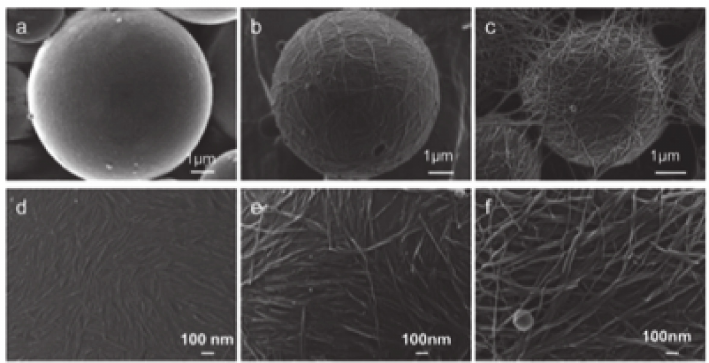
Figure 5. SEM images of polymerized styrene–water emulsions stabilized by cellulose nanomaterials of di ff erent sizes. ( a , d ) Cellulose nanocrystals from cotton, ≈ 200 nm in length. ( b , e ) Bacterial cellulose nanocrystals, ≈ 900 nm in length. ( c , f ) cellulose nanofibers from cladophora, ≈ 4 µ m in length. Reproduced from Ref [149] with permission from The Royal Society of